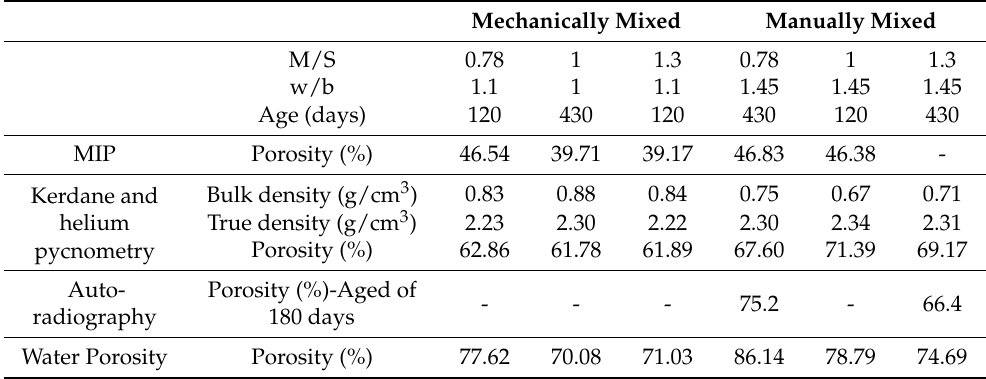
Figure 16. Pore size distribution by mercury intrusion porosimetry (MIP) of M-S-H samples with M/S = 0.78, 1.0 and 1.3, mixed mechanically ( a ) or manually ( b ). Table 6. Porosity of the M-S-H pastes according to MIP, kerdane and helium pycnometry, autoradiog- raphy, and water